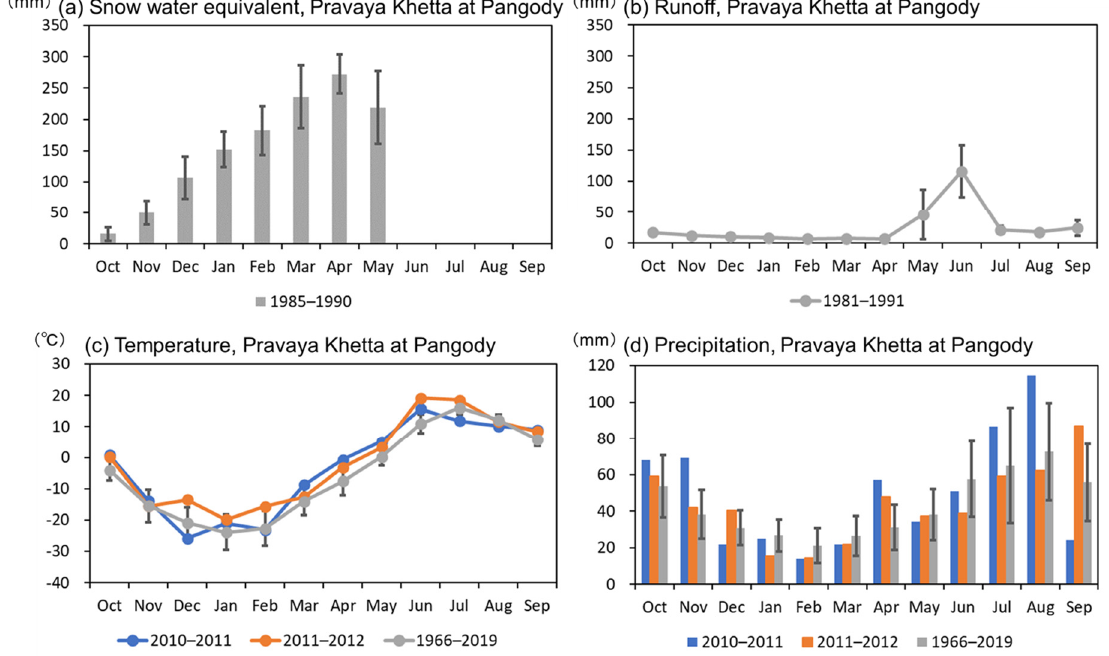
Figure 8. Same as Figure 7, but for Pravaya Khetta at Pangody in north WS. In ( a ) and ( b ), data for 2010–2011 and 2011–2012 are missing.